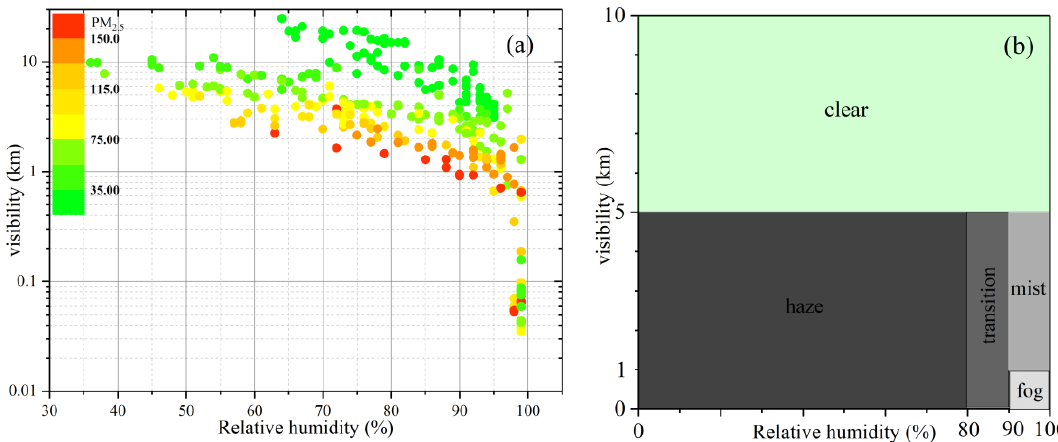
Figure 4. ( a ) the relation of visibility, Relative and PM 2.5 and ( b ) the classification in the haze-fog episode.